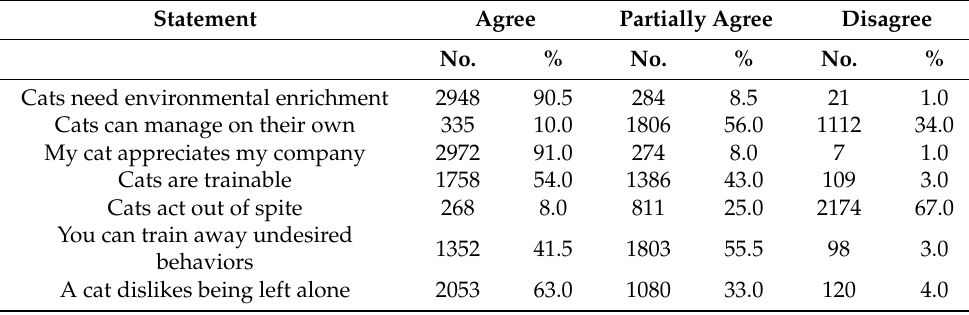
Table 2. The respondent ( n = 3253) agreement to different statements about cats.